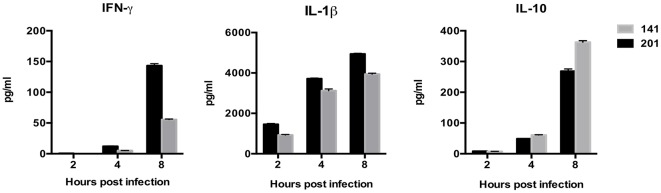
Human peripheral lymphocytes infected with the Y. pestis 201 strain secreted more abundant IFN-γ and IL-1β, and less immunosuppressive IL-10 than those infected with the 141 strain. Culture supernatants from the infected lymphocytes were collected at 2, 4, and 8 hpi and analyzed for the different cytokines using BDTM CBA Kits. Significantly higher IFN-γ and IL-1β levels were present in the supernatant from the 201-infected lymphocytes, while inflammatory inhibitory IL-10 was higher in the 141-infected lymphocytes at 8 hpi. Figures were drawn using Graphpad Prism 5.0, and the statistical significance of the differences in the cytokine levels between the different groups of samples were analyzed by two-way ANOVA analysis followed by Bonferroni post-tests.